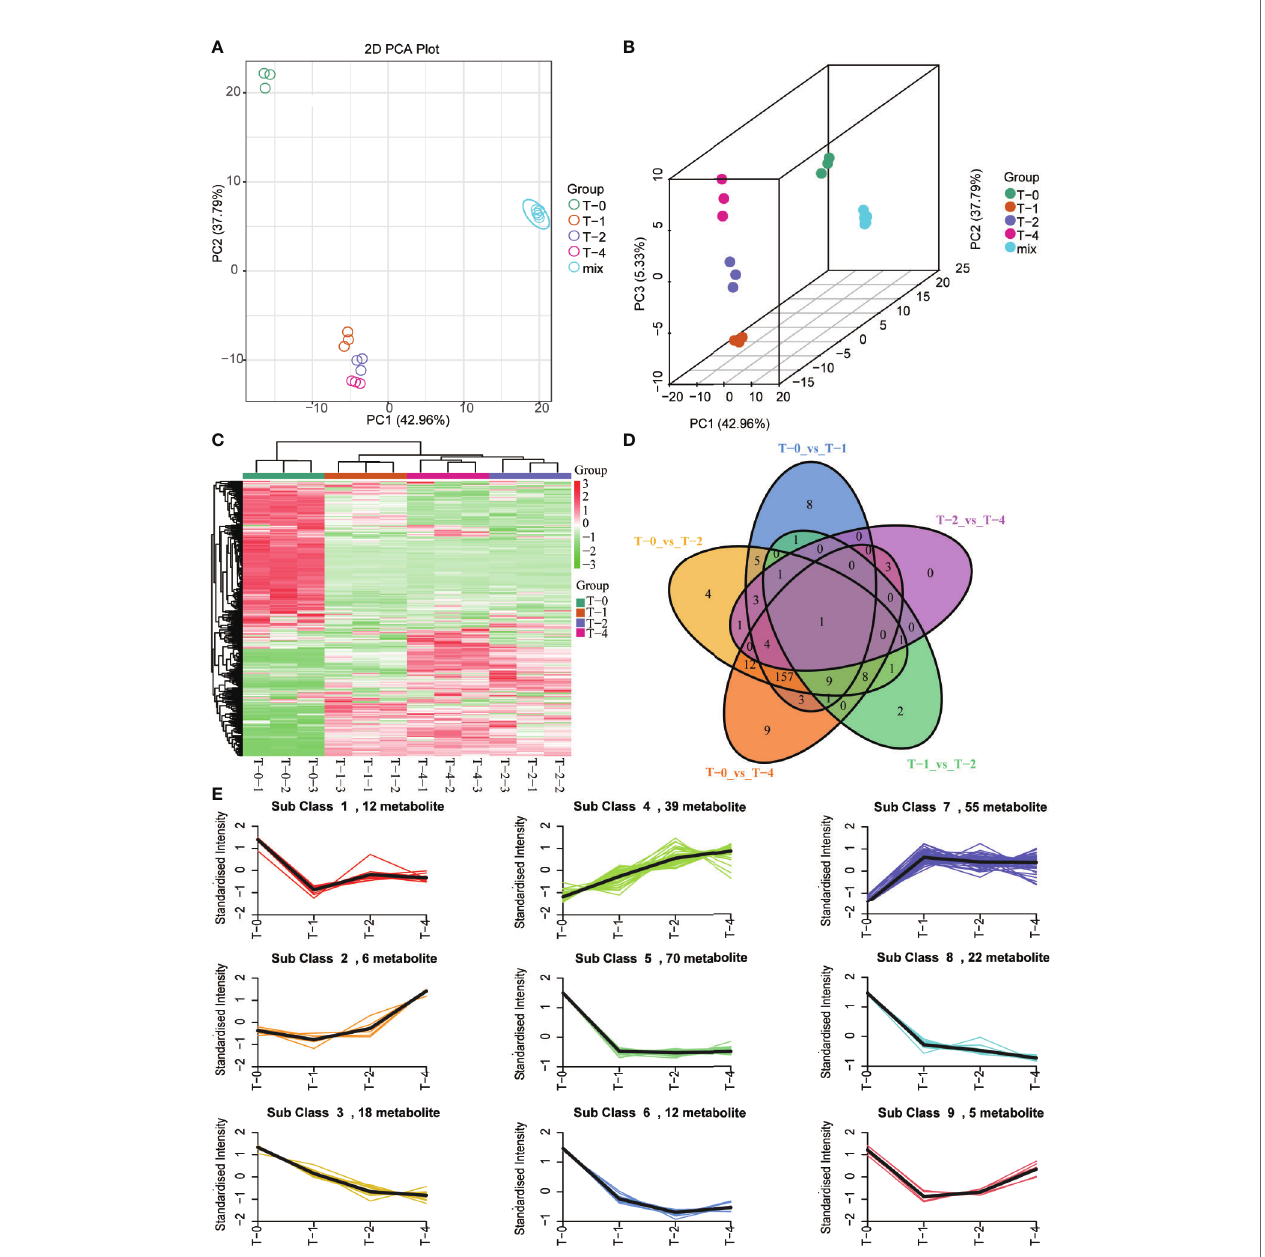
FIGURE 6 | Multivariate statistical analysis of methanol extracts of TR samples in different sulfur-fumigation time. (A) PCA plot; (B) 3D OPLS-DA plot; (C) heatmap; (D) venn; (E) relative content trend of metabolites in different sulfur-fumigation